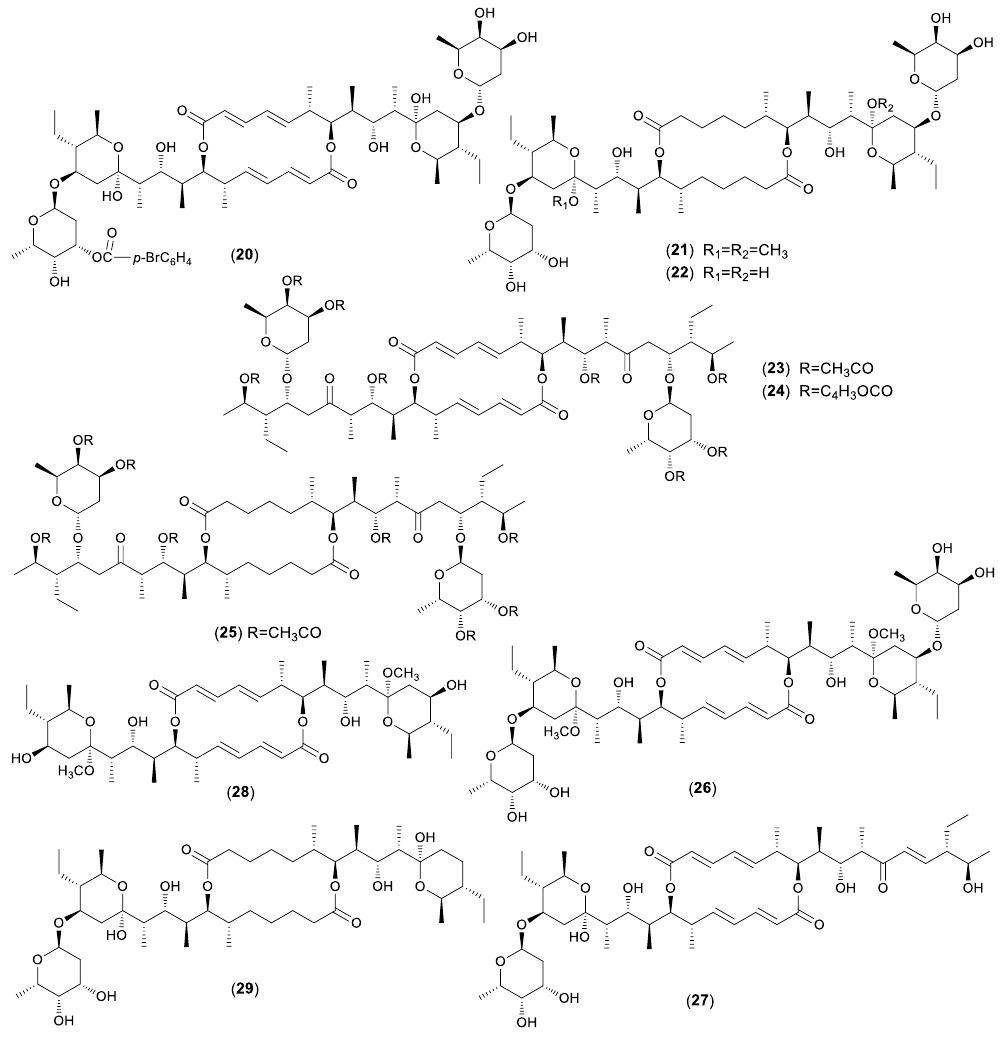
Figure 2. Structures of chemical derivatives of elaiophylin.